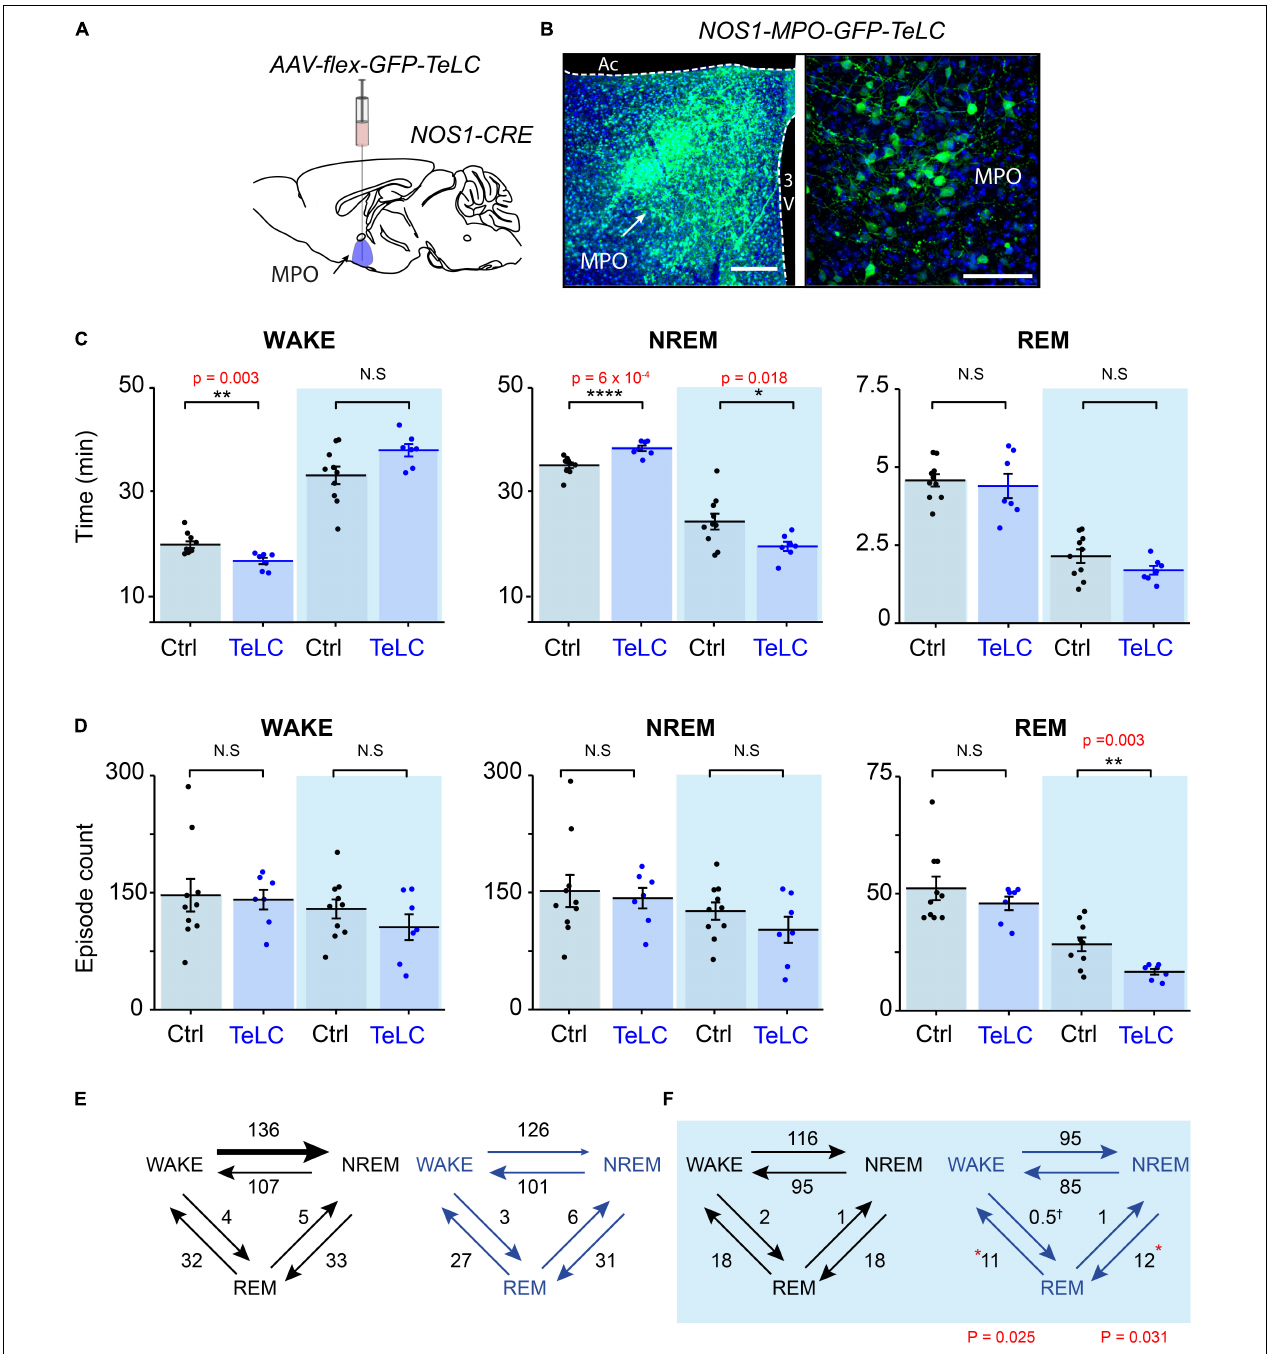
FIGURE 3 | Reducing transmitter release from NOS1 neurons in MnPO/MPO hypothalamus alters sleep amounts and the number of sleep episodes in a manner dependent on the light-dark cycle. (A) Schematic of the stereotaxic injection of AAV-flex-GFP-TeLC into the MnPO/MPO area of Nos1-CRE mice to generate Nos1-MnPO/MPO-GFP-TeLC mice. (B) Example histology from MnPO/MPO showing expression of the GFP-TeLC protein as detected with a GFP antibody; left picture, lower magnification view, scale bar is 200 µ m, right picture, higher magnification view, scale bar 100 µ m. (C) Quantification of sleep states for each mouse in the 12-h light or dark periods shown as average time in vigilance state per hour. Wakefulness in the light phase (two-tailed t -test, n = 7 and n = 10, p = 0.003), NREM in the light phase (two-tailed t -test, n = 7 and n = 10, p = 0.0006), NREM in the dark phase (two-tailed t -test, n = 7 and n = 10, p = 0.018). (D) The number of episodes of wake, NREM and REM between light and dark. REM in the dark phase (two-tailed t -test, n = 7 and n = 10, p = 0.003). (E) Analysis of sleep transitions between sleep states in the light phase. No differences were observed between groups. (F) The transitions between Nos1-MnPO/MPO-GFP-TeLC mice and Nos1-MnPO/MPO-GFP mice in the dark phase. Transitions from NREM to REM ( p = 0.025) and from REM to wake ( p = 0.031), from two-tailed t -test, n = 7 and n = 10. Multiple comparisons were accounted for using the Benjamini-Hochberg procedure at a false discovery rate of 5%. * P < 0.05, ** P < 0.01, N.S, not